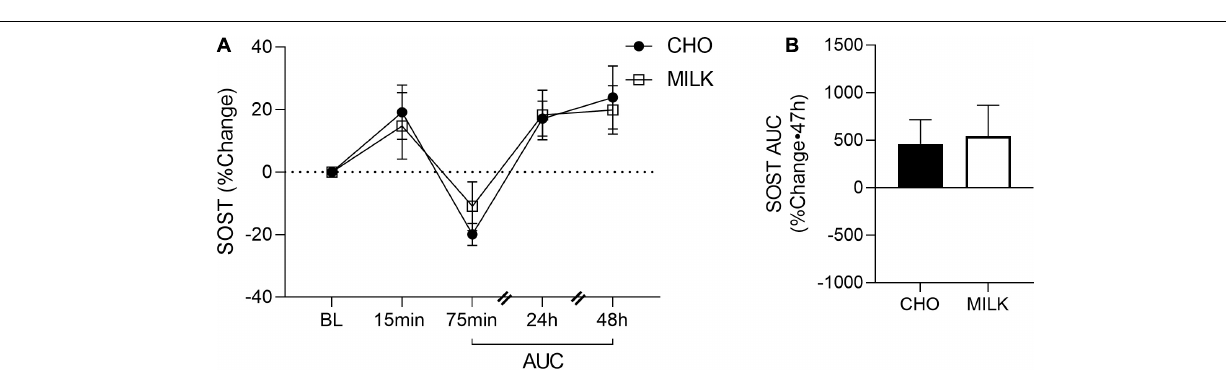
FIGURE 4 | Percent change post-exercise (A) and area under the curve from 75-min to 48-h (B) for sclerostin (SOST) in the CHO and MILK trials. Values are means ± SEM. n = 13. BL, baseline; AUC, area under the